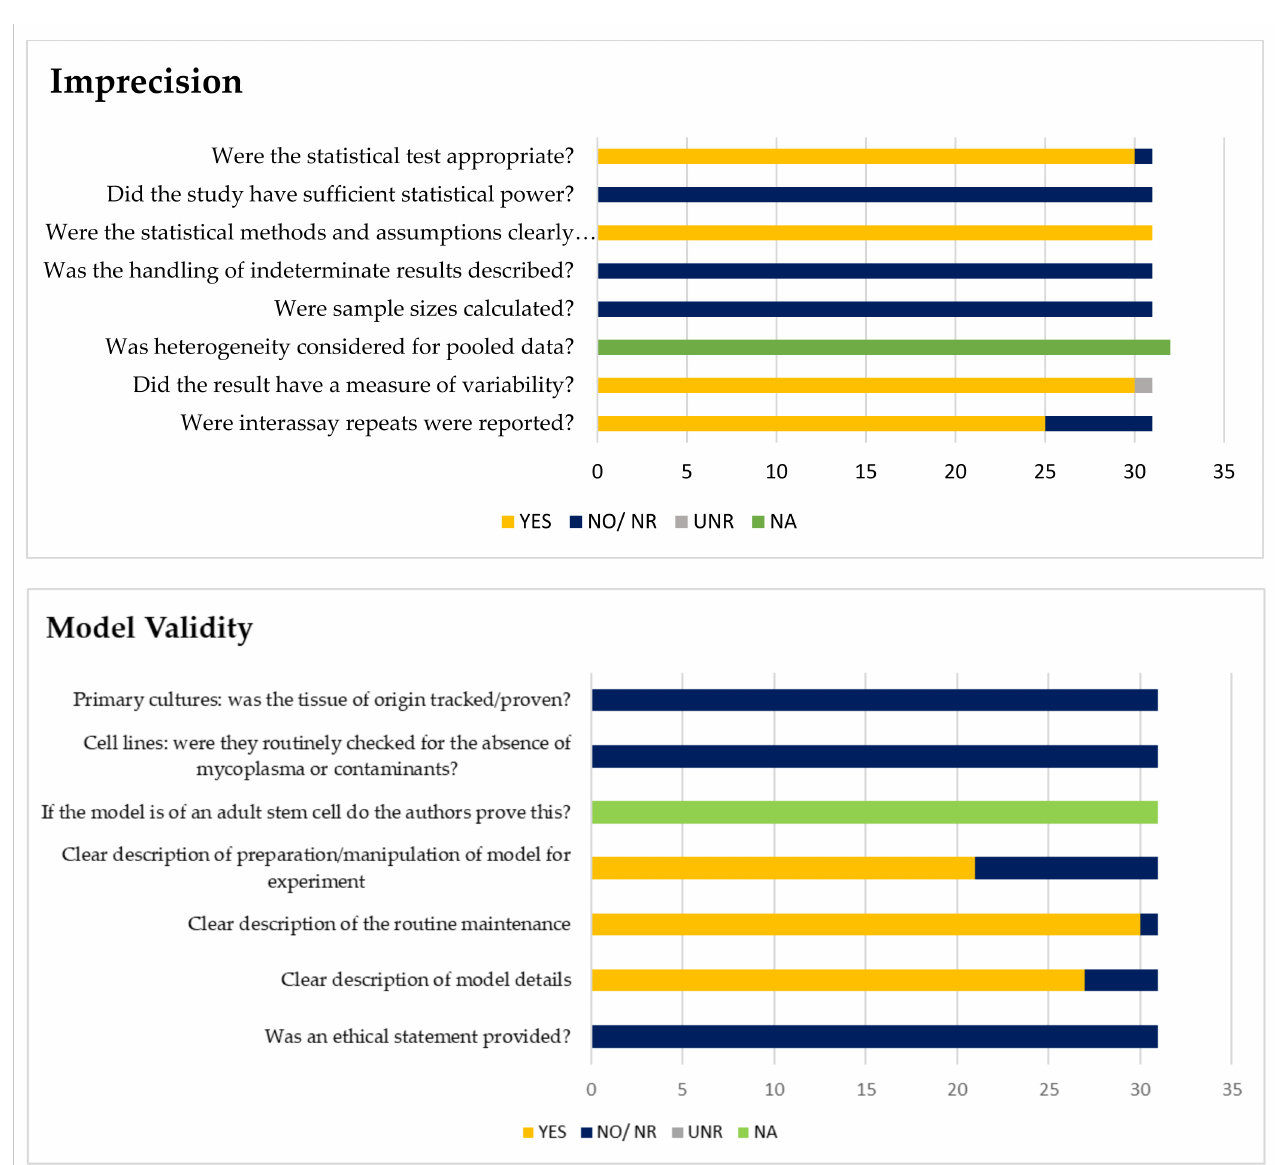
Figure 2. Assessments of imprecision and model validity. Yellow bars = number of studies for judgments of ‘yes’. Dark blue bars = number of studies for judgements of ‘no’ or ‘not reported’. Light grey bars = number of studies ‘unclear (UNR)’ for question (unclear for imprecision). Green bars = number of studies for judgements of ‘not applicable